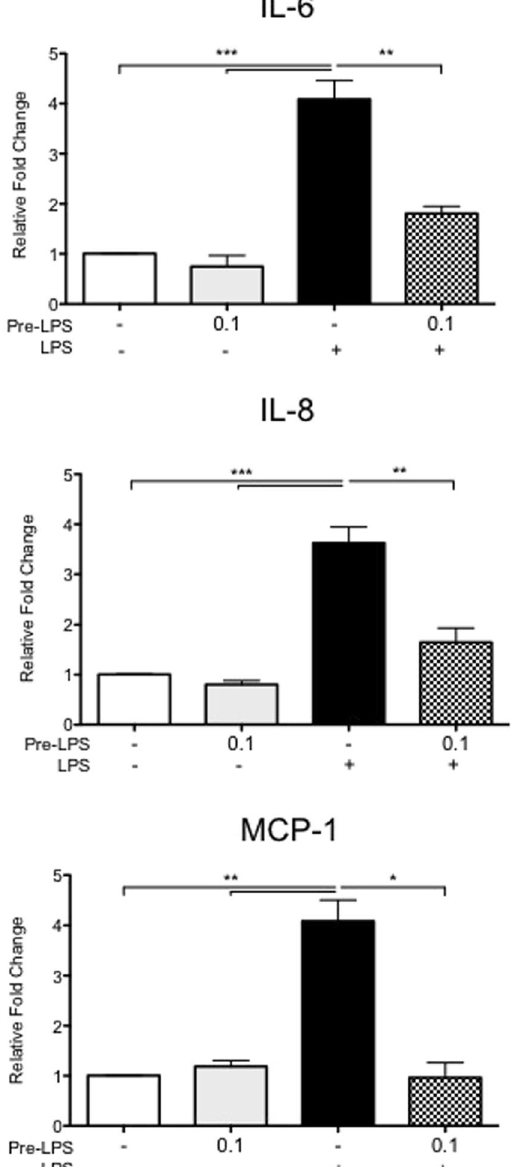
Figure 6. Effect of low-dose LPS pre-treatment prior to high-dose LPS stimulus on cytokine secretions by hTERT-HM cells. Cells were pre-treated with 0.1 μ g/mL of LPS prior to a subsequent treated with (checkered grey bars) or without (solid grey bars) LPS (100 ng/mL). Values are presented as fold change (mean ± SEM) relative to untreated control (white bars). Statistical significance was determined by One-way ANOVA followed by Dunnett’s post-test relative to LPS stimulus (solid black bars). * P < 0.05; ** P < 0.01; *** P < 0.001 (n =